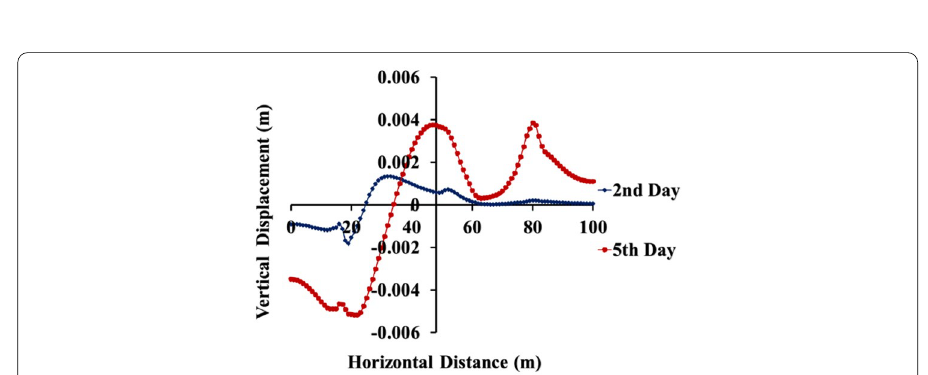
Fig. 17 Vertical displacement profile along the base of the dam during reservoir